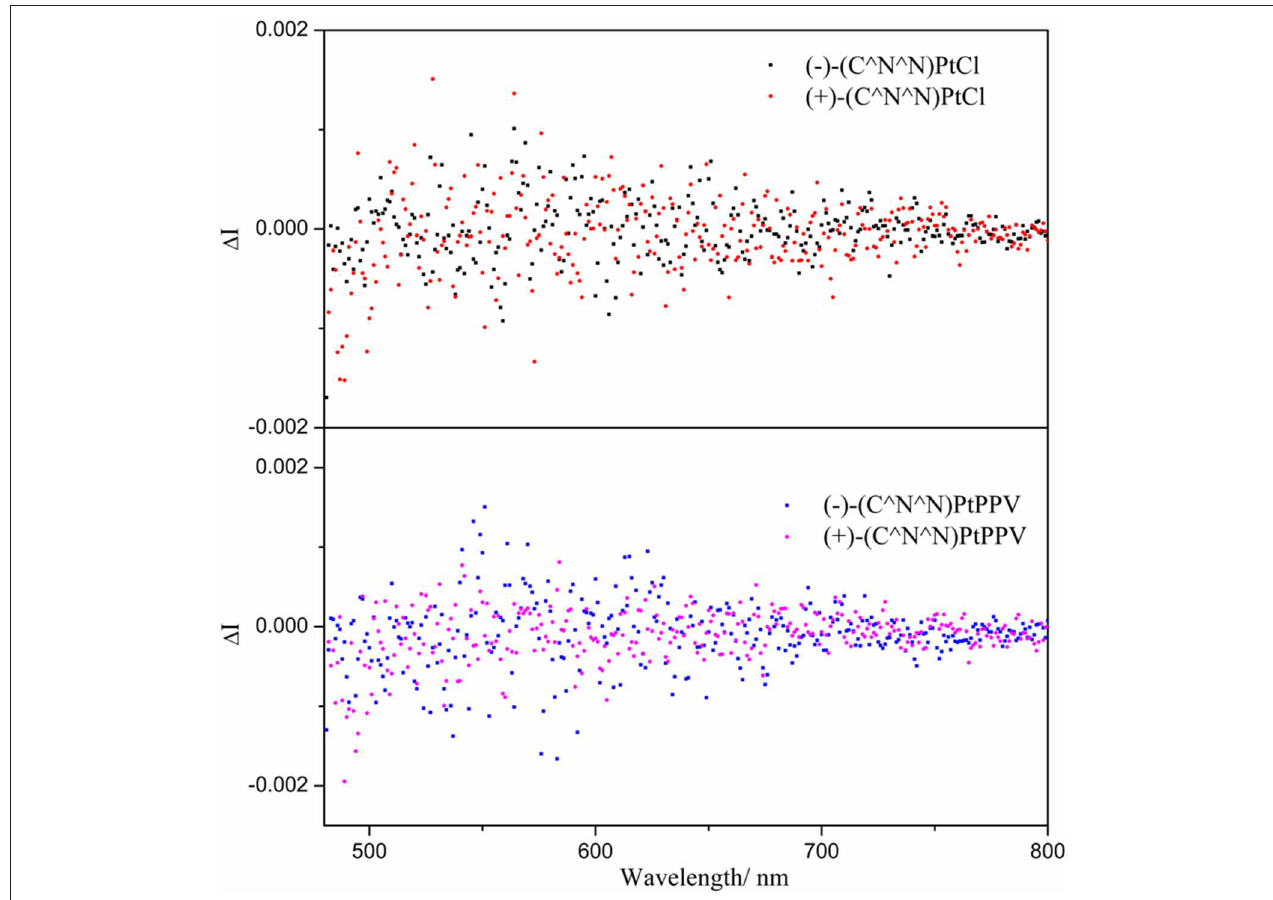
FIGURE 3 | CPL spectra of (–)-(C ∧ N ∧ N)PtCl and ( + )-(C ∧ N ∧ N)PtCl, (–)-(C ∧ N ∧ N)PtPPV and ( + )-(C ∧ N ∧ N)PtPPV in CH 2 Cl 2 (10 − 3 mol L − 1 ) at T = 298K.